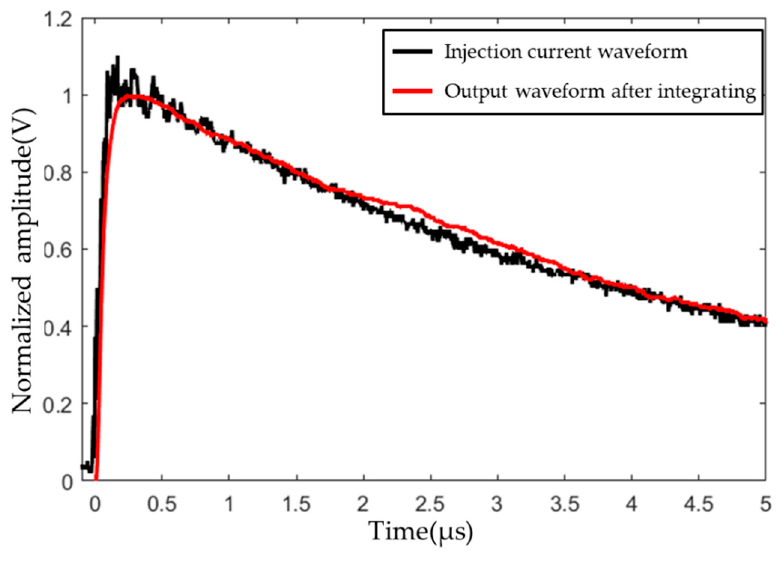
Figure 11. Comparison of the lightning current component H injection (black line) and integrated waveforms (red line 1).